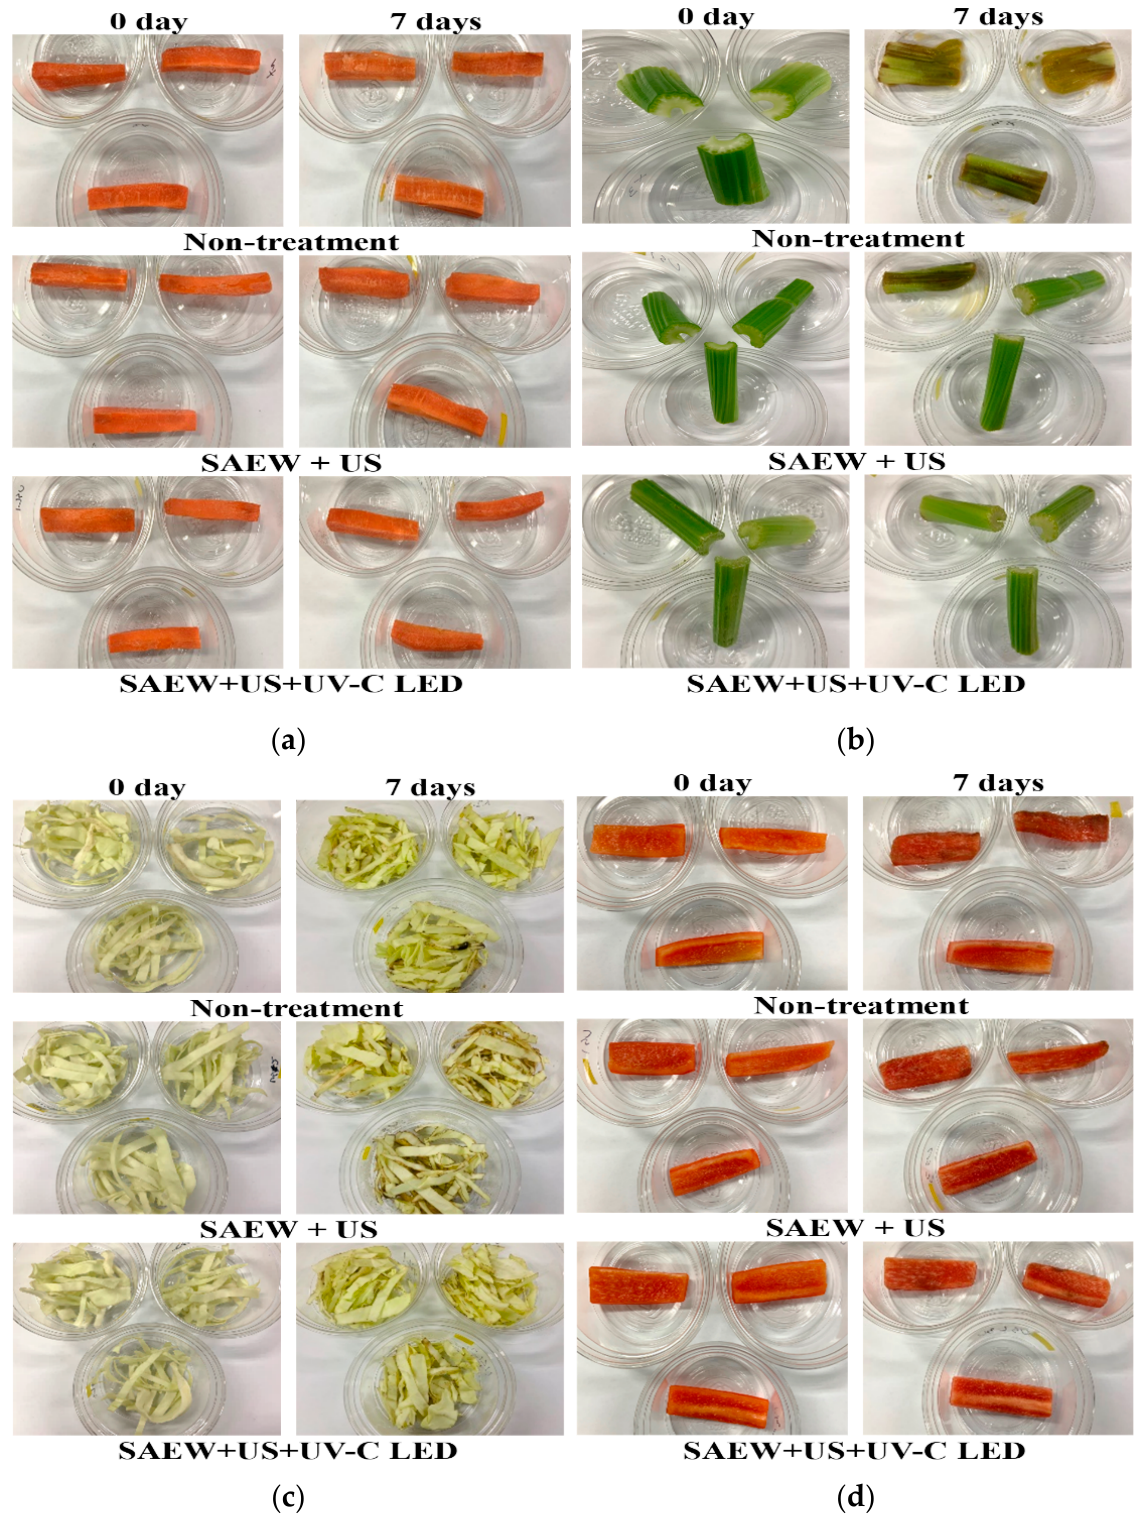
Figure 5. Effect of combined treatments on visible qualities in various fresh-cut vegetables after storage for 7 days at 15 °C. ( a ) Carrot, ( b ) celery, ( c ) cabbage, ( d ) paprika; non-treatment, no extra wash with a sanitizer; SAEW, slightly acidic electrolyzed water; US, ultrasounds; UV-C LED, ultraviolet-C light-emitting diodes (275 nm).